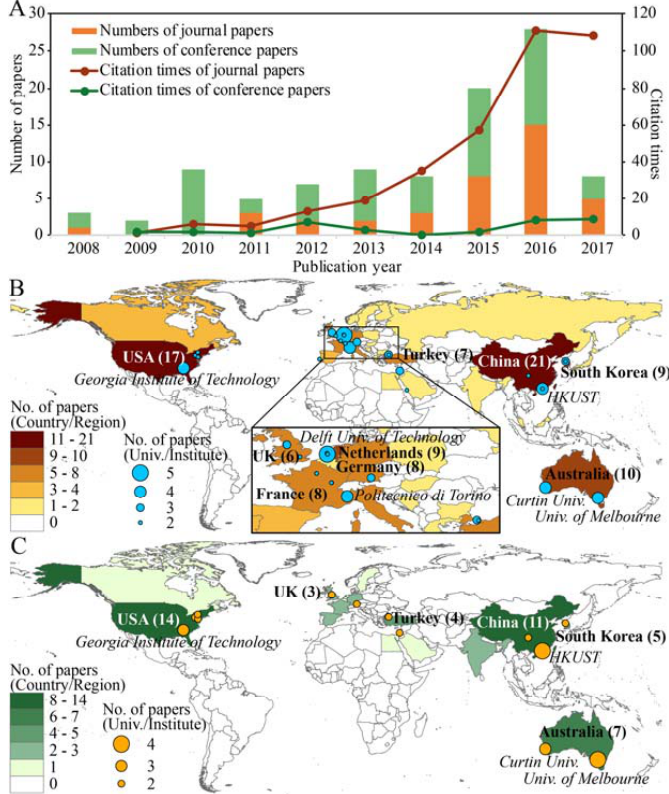
Figure 1. Trends and worldwide distributions of BIM-GIS integration during the past ten years: ( A ) trends of publications; ( B ) map of publications; and ( C ) map of the Science Citation Indexed (SCI) or Social Sciences Citation Indexed (SSCI) indexed journal